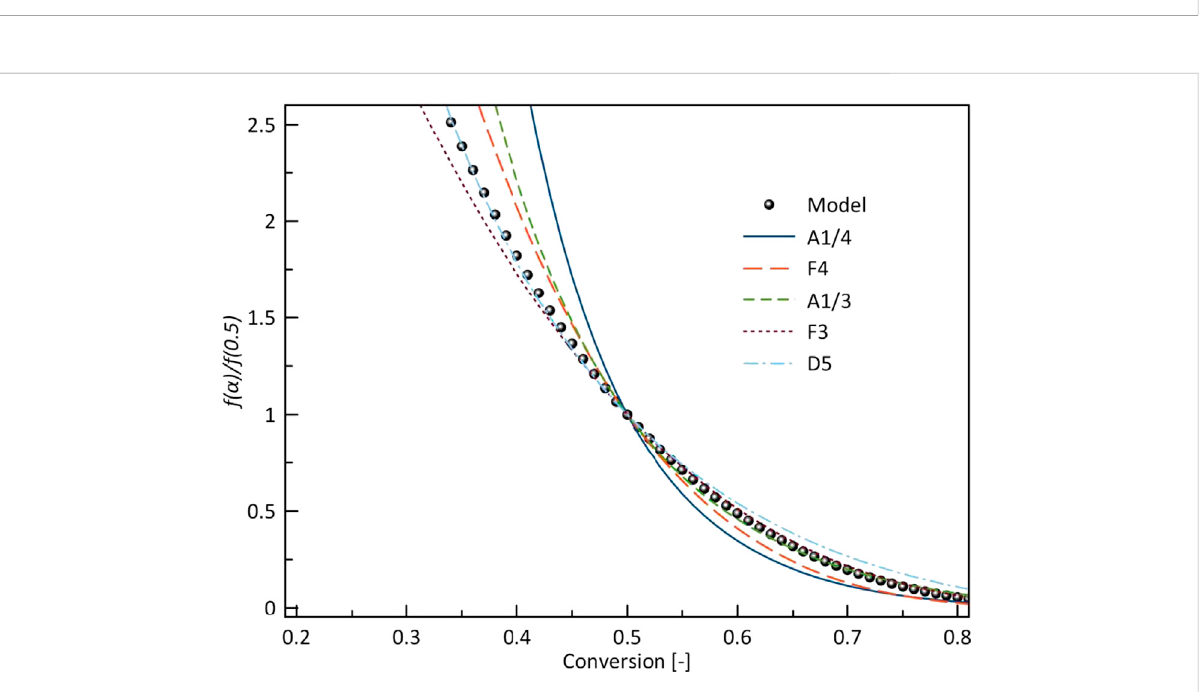
FIGURE 9 Normalized model function f( α )/f(0.5) with different ideal